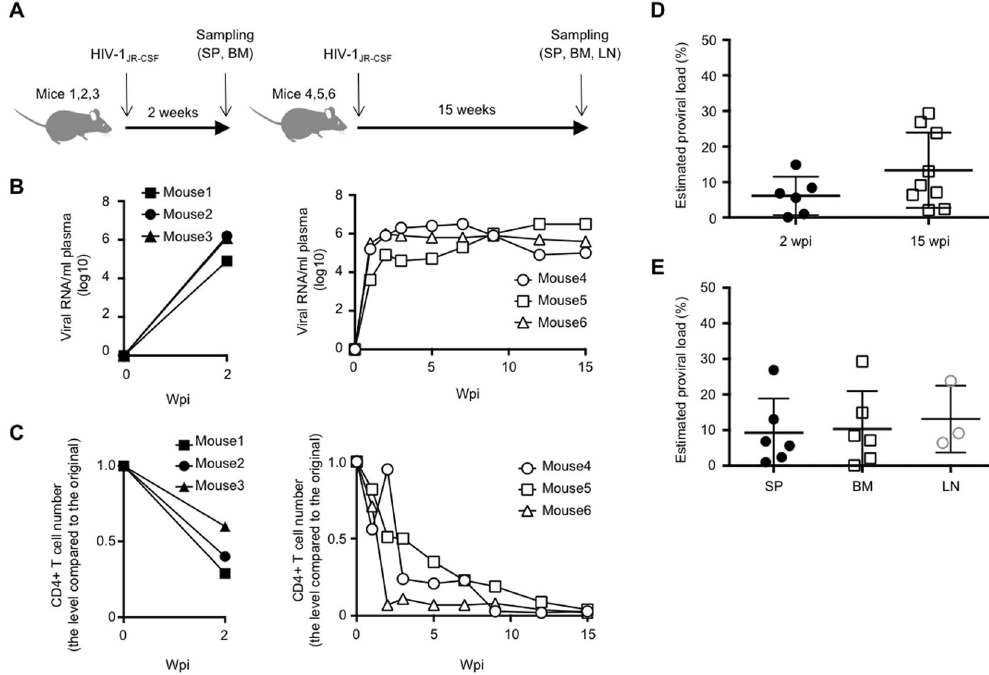
Figure 1. HIV-1 infection in the humanized mice. ( A ) Diagram showing the experimental design. Bone marrow (BM) and spleen (SP) were collected from 2 wpi mice and BM, SP, and lymph node (LN) were collected from 15 wpi mice for clonality analysis. Longitudinal analysis of plasma viral load ( B ) and CD4 + T-cell number ( C ) in 2 wpi and 15 wpi humanized mice. ( D ) Comparison of proviral load between 2 wpi and 15 wpi mice. ( E ) Comparison of proviral load among different tissues, SP, BM, and